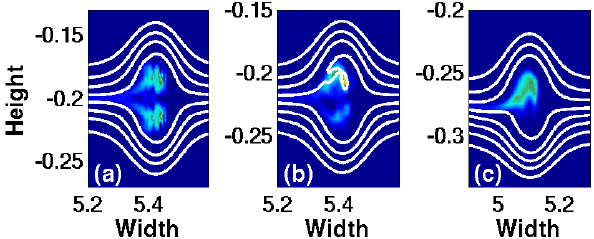
Fig. 6. A comparison of the largest mode-2 wave at time t = 100s for a pycnocline centred at (a) − z 0 = H/ 2, (b) − z 0 = H/ 2 + 0 . 05 H , and (c) − z 0 = H/ 2 + 0 . 20 H . Eight isocontours of density are overlayed to depict the location of the mode-two wave. It is very clear the off-centre location of the pycnocline causes the tracer to lose its symmetry about the centre of the mode-2 wave. Colorbar is saturated to 10% of its maximum